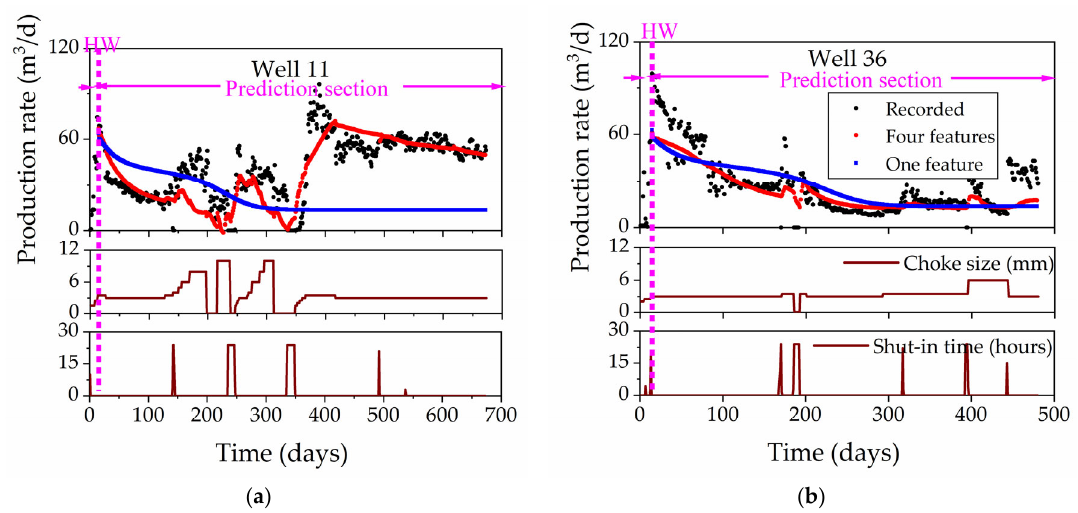
Figure 13. Comparison of the one-feature model and the four-feature model with the Iterative approach under multiple factors; ( a ) Well 11; ( b ) Well 36.